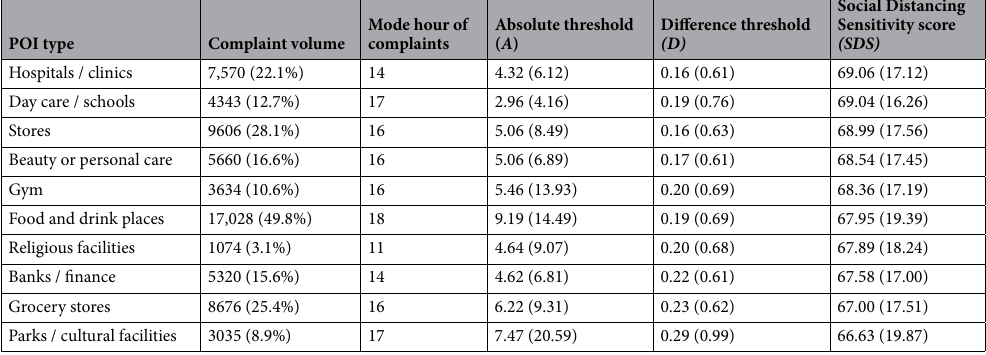
Table 1. Descriptive statistics of POI-level sensitivity measurements by establishment type. This table is sorted by sensitivity (descending) and the absolute threshold unit is the number of visits per 10,000 sq.ft. of POI floor area for each six-hour time interval. Mean values are shown with standard deviations in